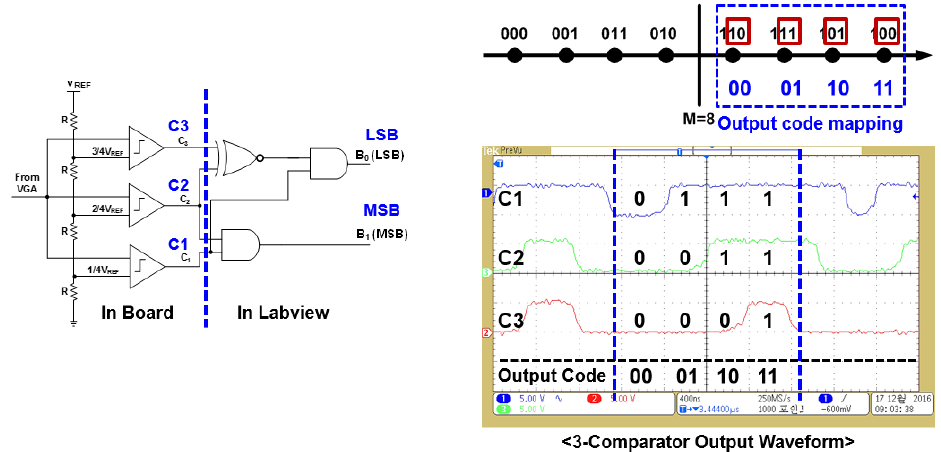
Figure 14. Measured digital encoding waveforms using LabVIEW (The meaning of the Korean is the same as they are in Figure 13).